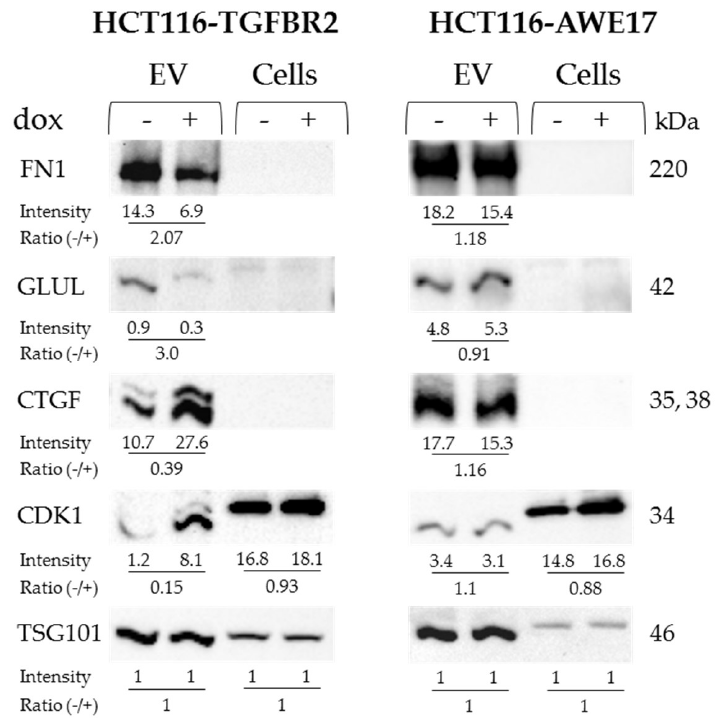
Figure 6. Validation of TGFBR2-regulated EV proteins. Representative TGFBR2-regulated EV proteins (FN1, GLUL, CTGF, CDK1) were analyzed on Western blots in at least two biological replicates. The non-regulated EV marker protein TSG101 was used as a loading control. EVs derived from HCT116-AWE17 cells served as a control for dox-related effects. Band intensities of proteins and calculated ratios are shown below each lane and were normalized to TSG101 set to 1. Protein sizes are indicated.